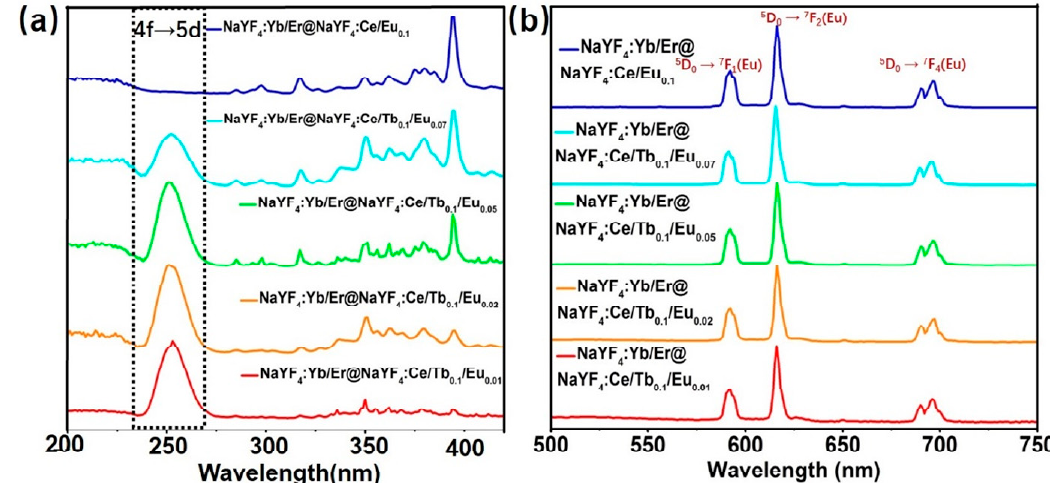
Figure 5. ( a ) Photoluminescence excitation spectra of core-shell-structured microrods monitored at 615 nm from Eu 3+ . ( b ) Emission spectra of corresponding samples at 395 nm excitation under the same condition.